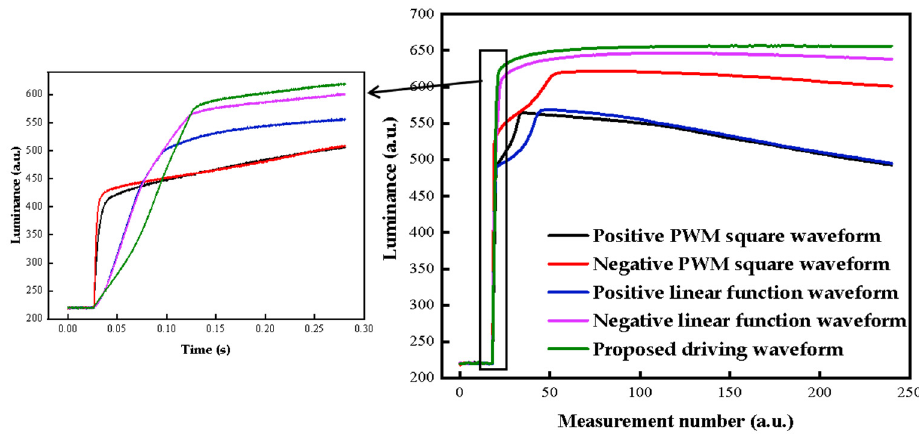
Figure 12. Performance comparison of driving waveforms. Luminance curves changed with time by conventional driving waveforms and the proposed driving waveform. The maximum luminance value could be obtained when the EWD was driven by the proposed driving waveform.